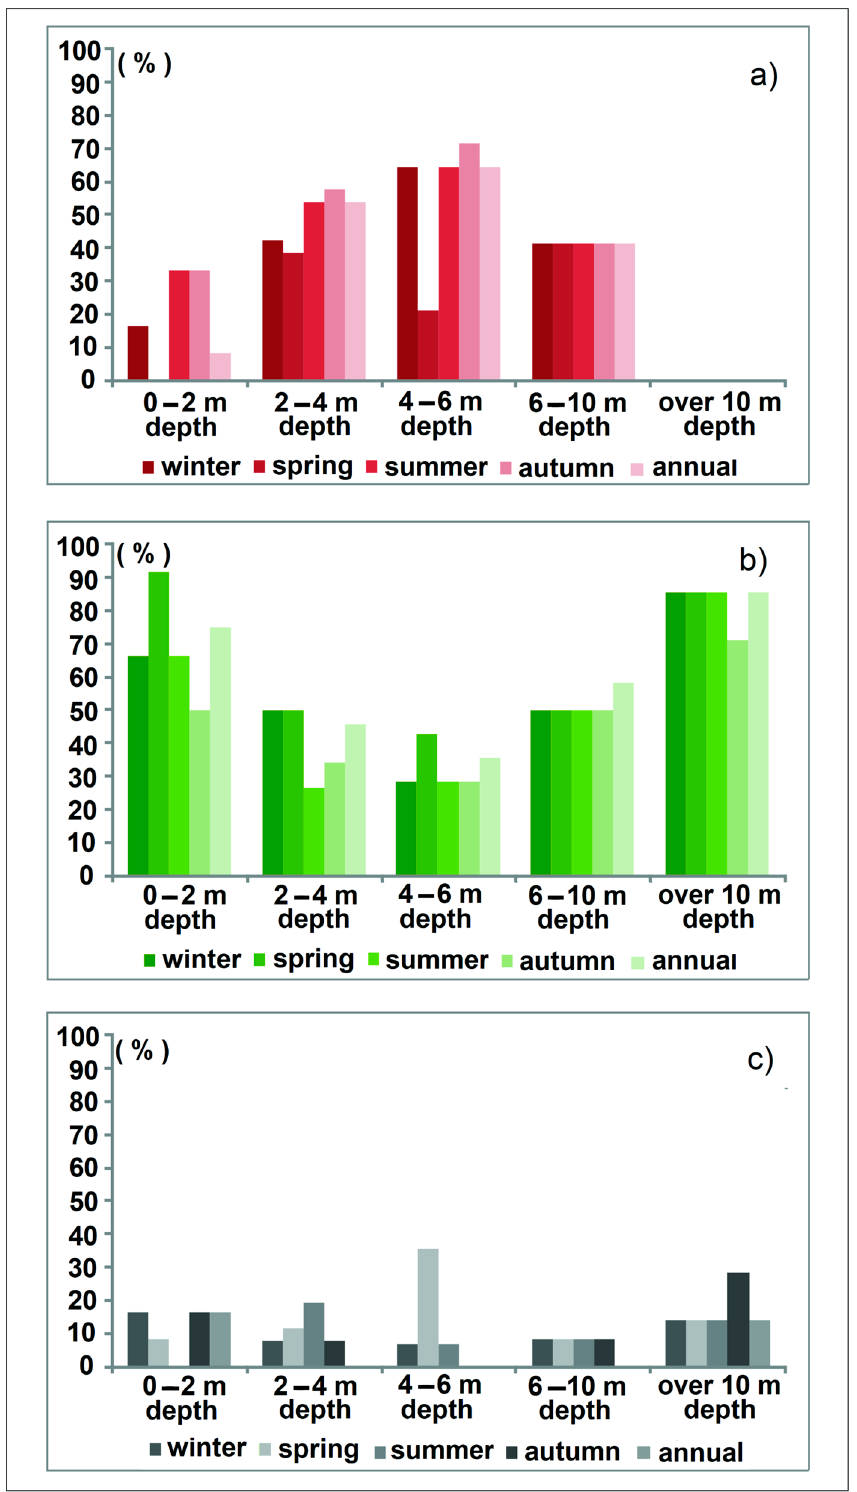
Figure 6. Positive ( a ), negative ( b ), and no trend ( c ) of slope frequency for different classes of groundwater level. Table 1. Changes in seasons and annual groundwater level according to the ITA index.